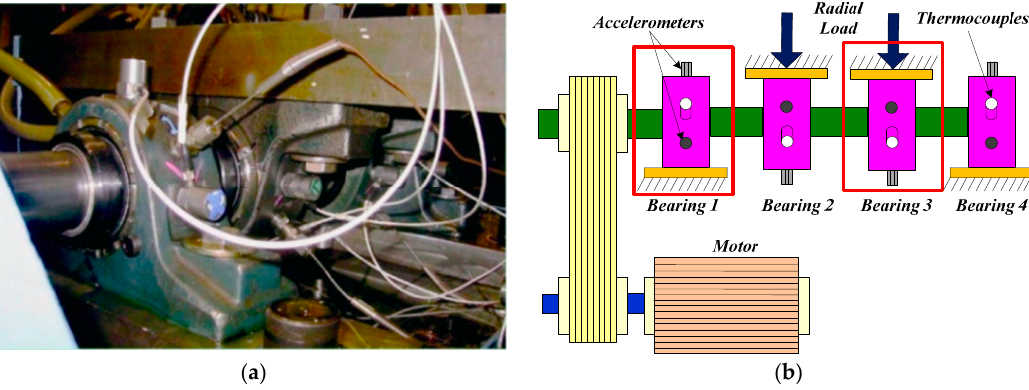
Figure 3. Experimental setup. ( a ) Physical experimental platform; ( b ) Schematic diagram [28,29].